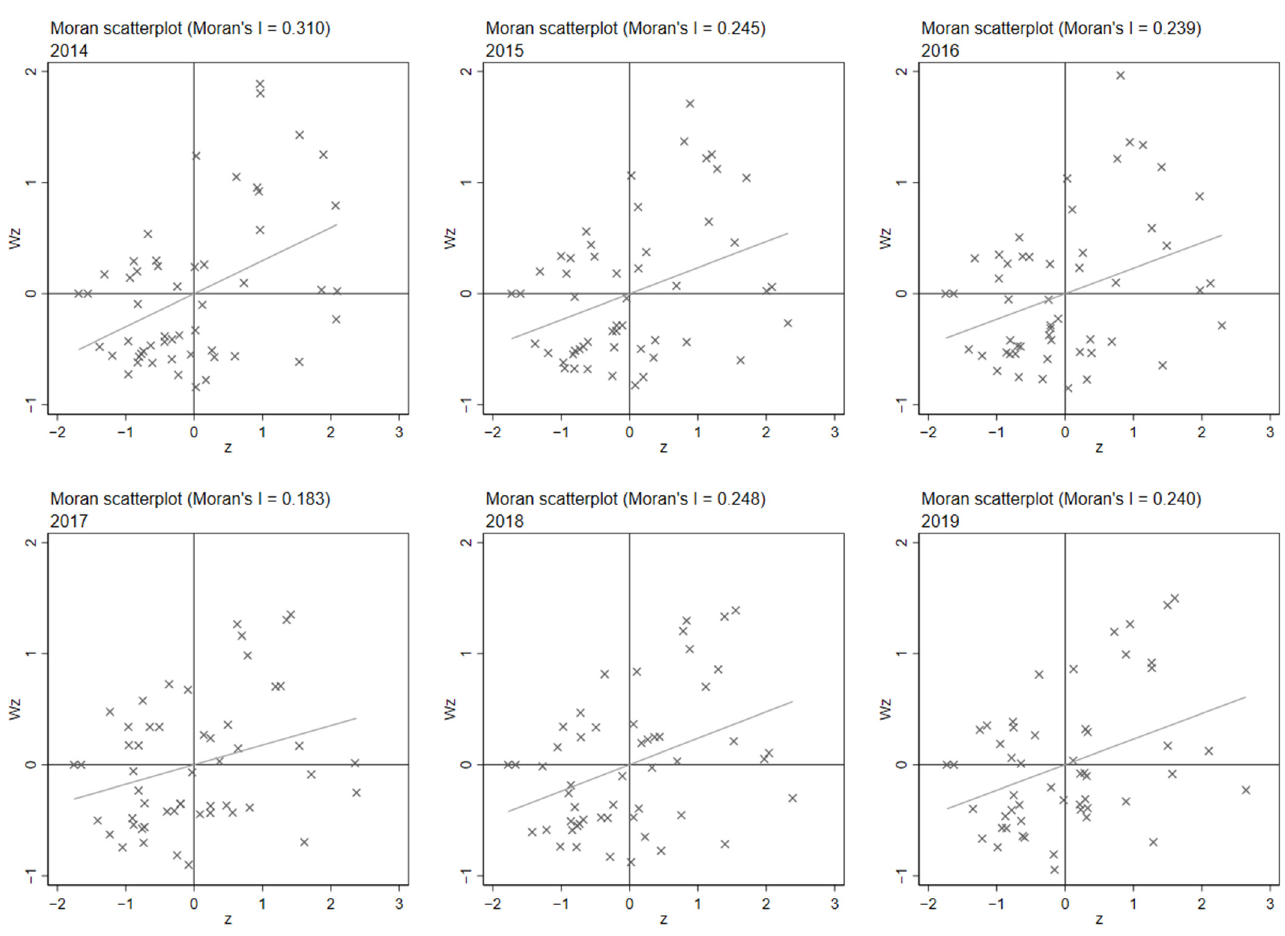
Figure 4. Scatter plot of Moran